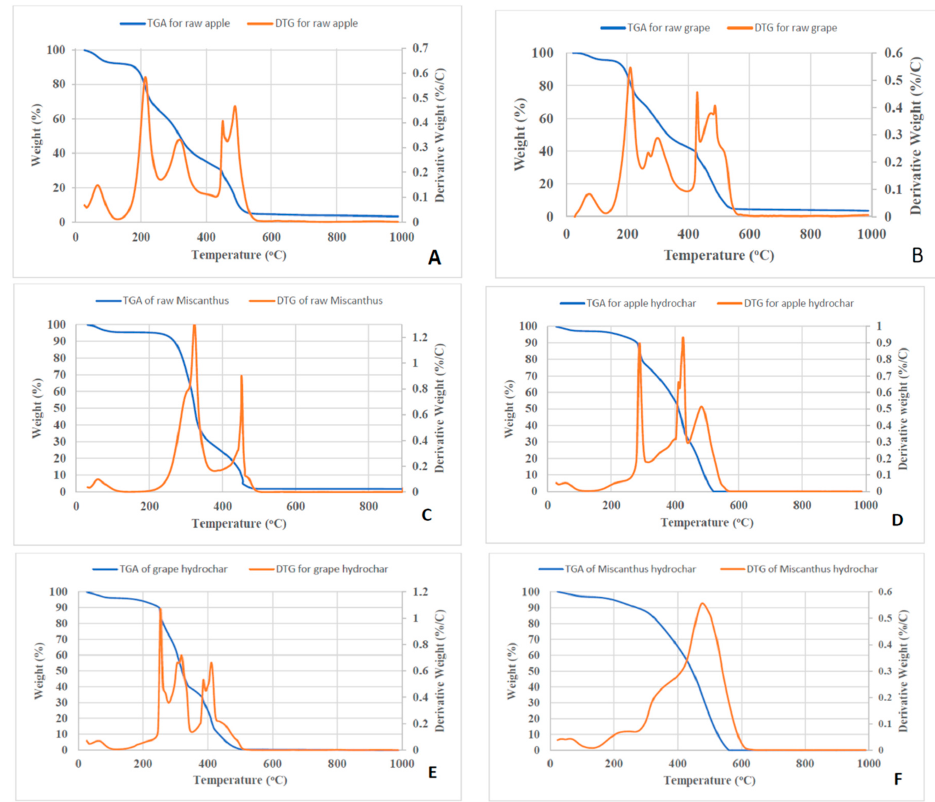
Figure 4. Thermogravimetric analysis/derivative thermogravimetric (TGA/DTG) graphs for ( A ) raw RA, ( B ) raw GP, ( C ) raw Miscanthus , and samples hydrothermally treated at 260 °C of: ( D ) RA, ( E ) GP, and ( F ) Miscanthus .